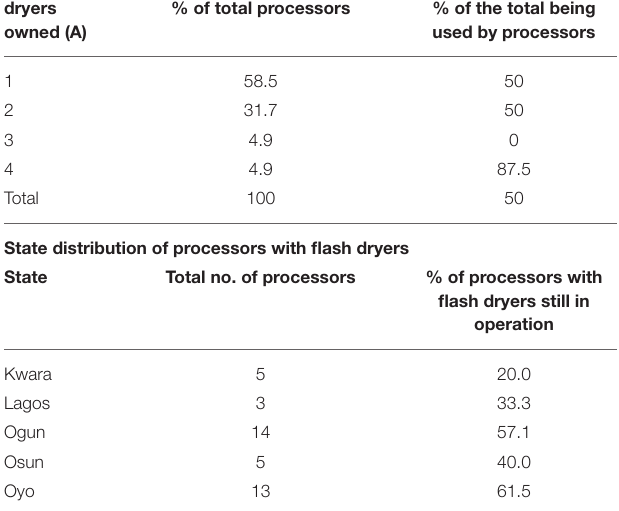
TABLE 2 | Number of flash dryers in use. No. of flash